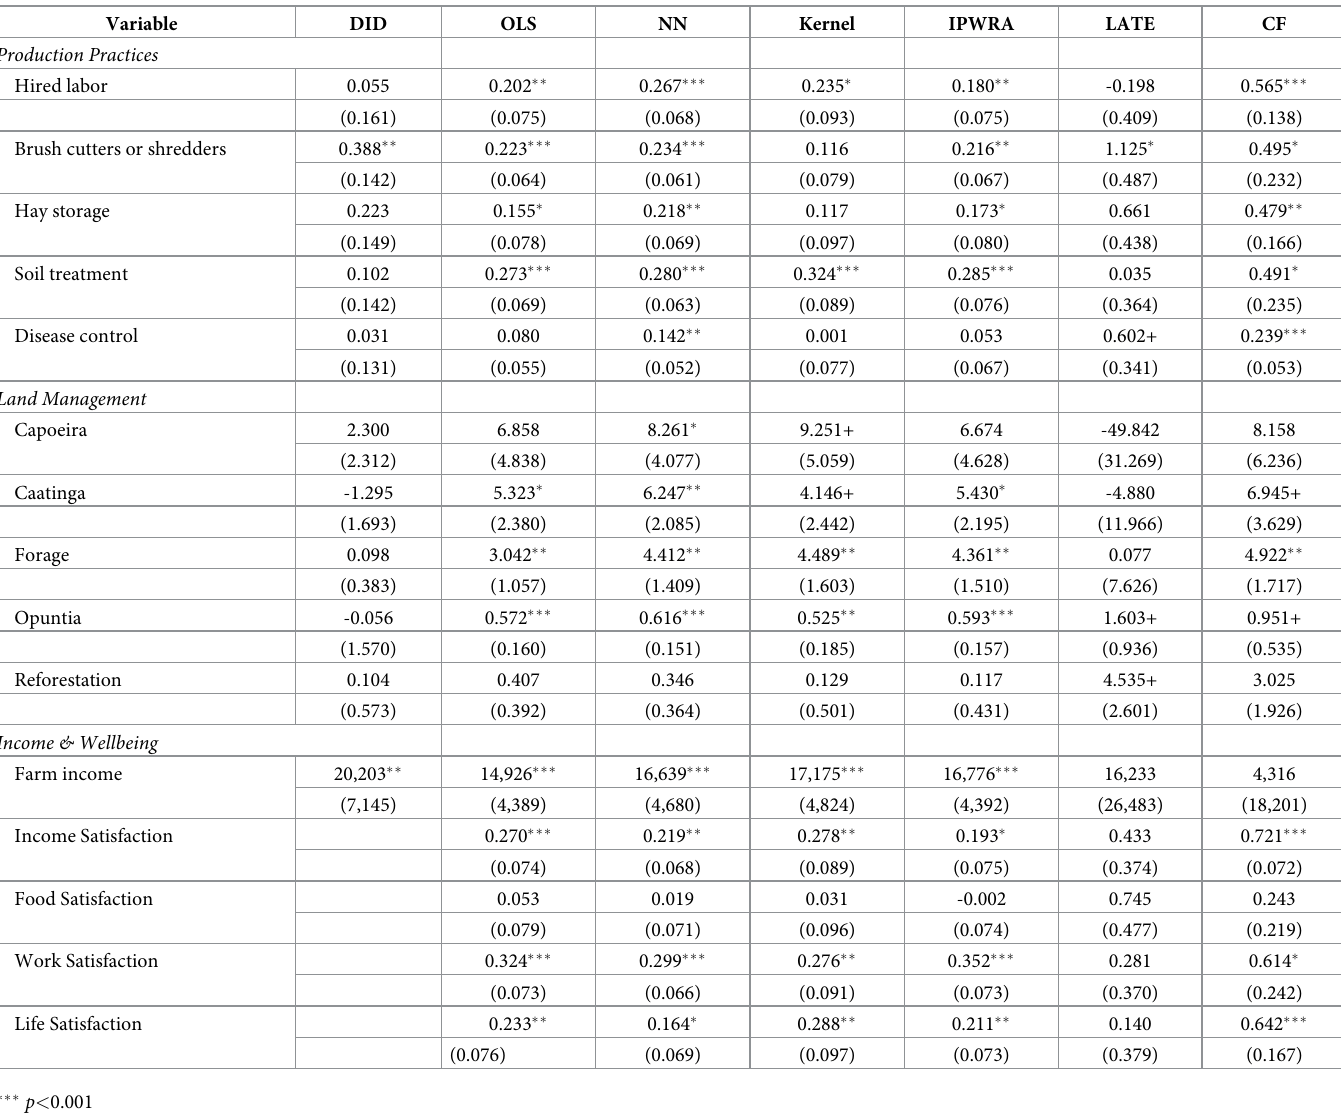
Table 3. Estimates for the impacts of the MAIS (standard deviation between